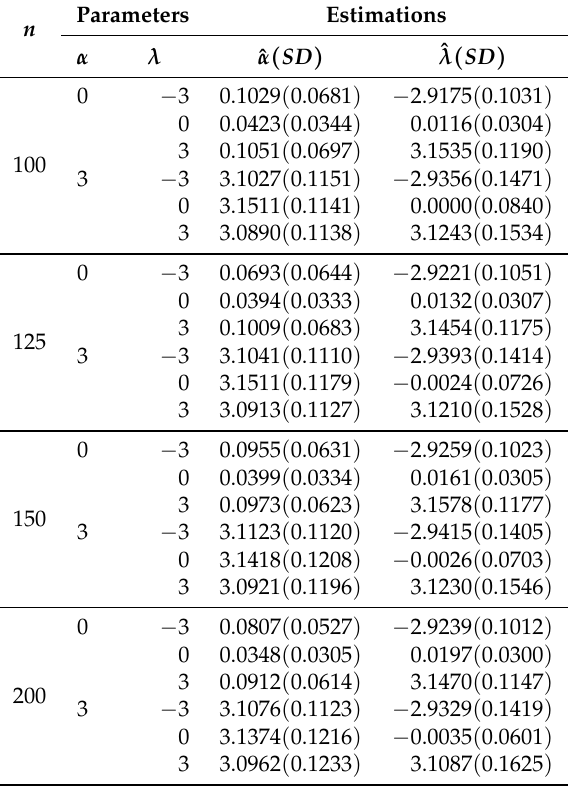
Table 5. Empirical means and standard deviations for ML estimators using Nelder-Mead method (with µ = 0 and σ =